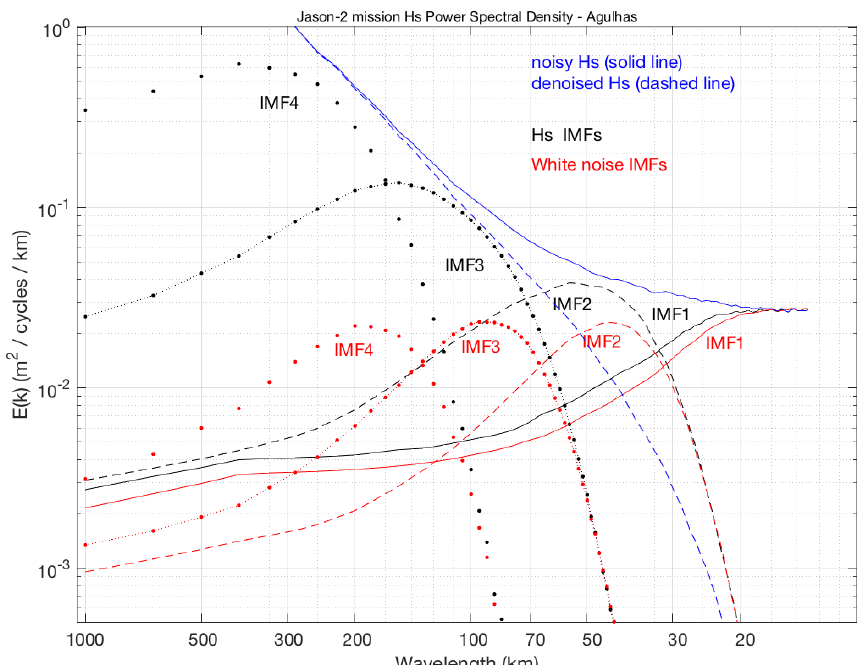
Figure 9. Mean Power Spectral Density (PSD) of the first four IMFs, for white noise (red curves) and JASON-2 SWH along-track mea- surements (black curves), and mean PSD of the corresponding noisy (solid blue line) and denoised (dashed blue line) JASON-2 SWH measurements. The PSD is the average of PSDs computed over all data segments covering the years 2014 to 2016 in the Agulhas region (45–33 ◦ S, 10–35 ◦ E). From Quilfen and Chapron